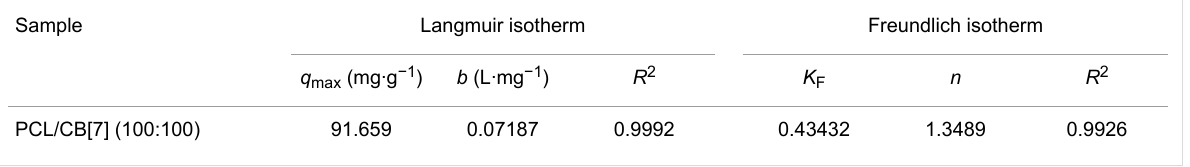
Table 1: Langmuir and Freundlich isotherm fitting parameters for the adsorption of MB onto PCL/CB[7] (100:100) nanofiber membranes. Sample